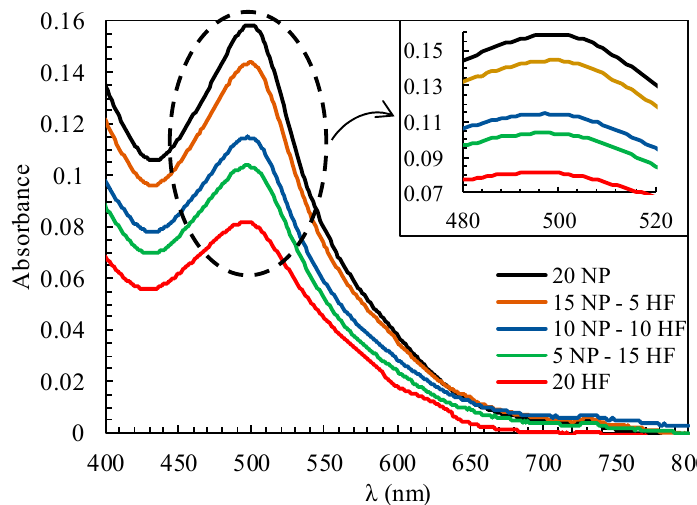
Figure 6. UV-Vis absorption spectra of the solutions containing dyes adsorbed by various photoanodes.